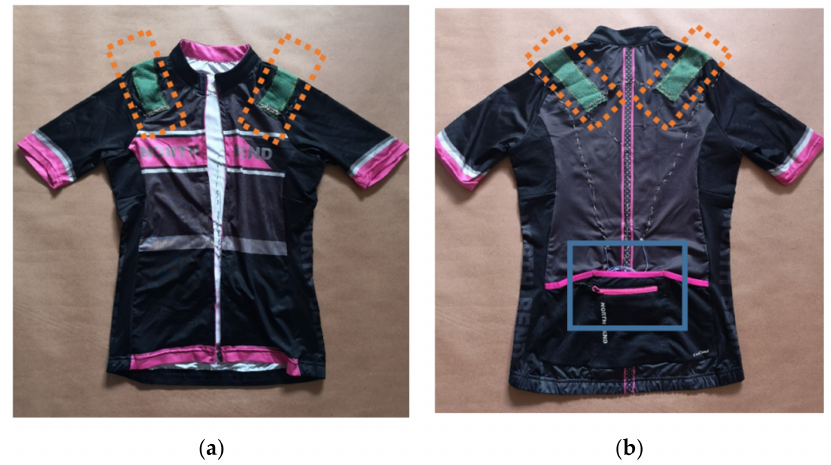
Figure 2. The Double Aid (DAid) smart shirt system (( a ) front and ( b ) back) with a textile stretch sensor on each shoulder (marked by the dashed lines); the pocket on the back (marked by the blue line) is used for the data acquisition module.